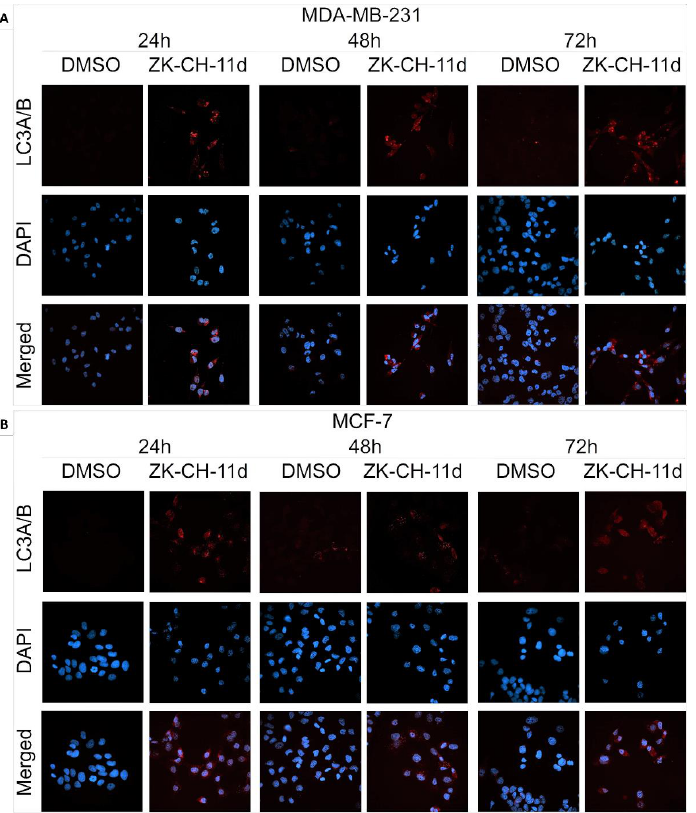
Figure 18. Immunofluorescence detection of LC3A/B in MDA-MB-231 ( A ) and MCF-7 ( B ) cells treated with chalcone ZK-CH-11d. Red represents the LC3A/B protein and blue represents DAPI-stained nuclei. The figure is a representative average of three independent experiments. Magnification: 60 ×